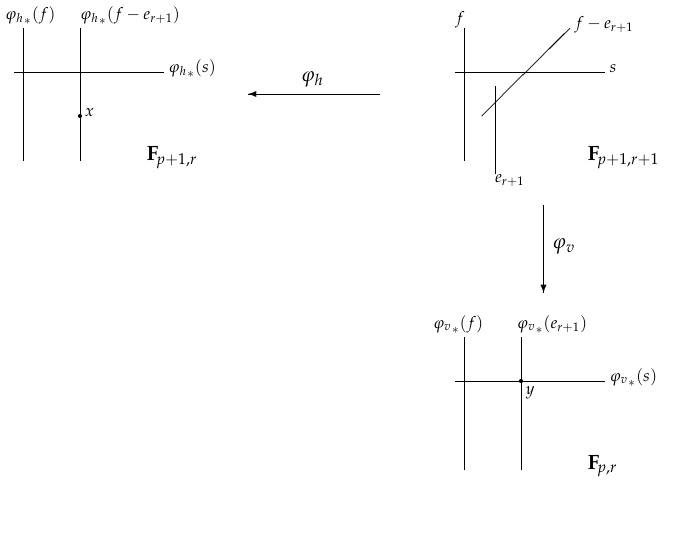
Figure 1. Monoidal